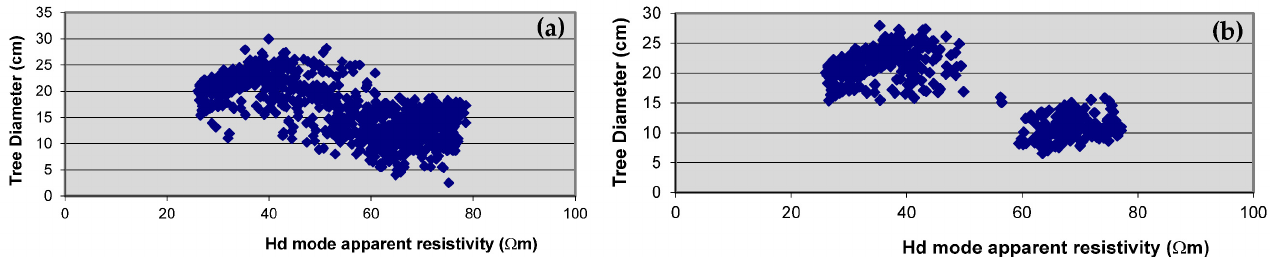
Figure 4. Tree diameter versus Hd-mode apparent resistivity at tree location: ( a ) for the entire population of trees (Zones A to D) and ( b ) for Zones A 1 and B (excluding trees in the transition area and the 5% most extreme cases). Correlation coefficients: − 0.70 (a); − 0.77 (( a ) with the conditions applied in ( b ); not shown); and − 0.83 ( b ).